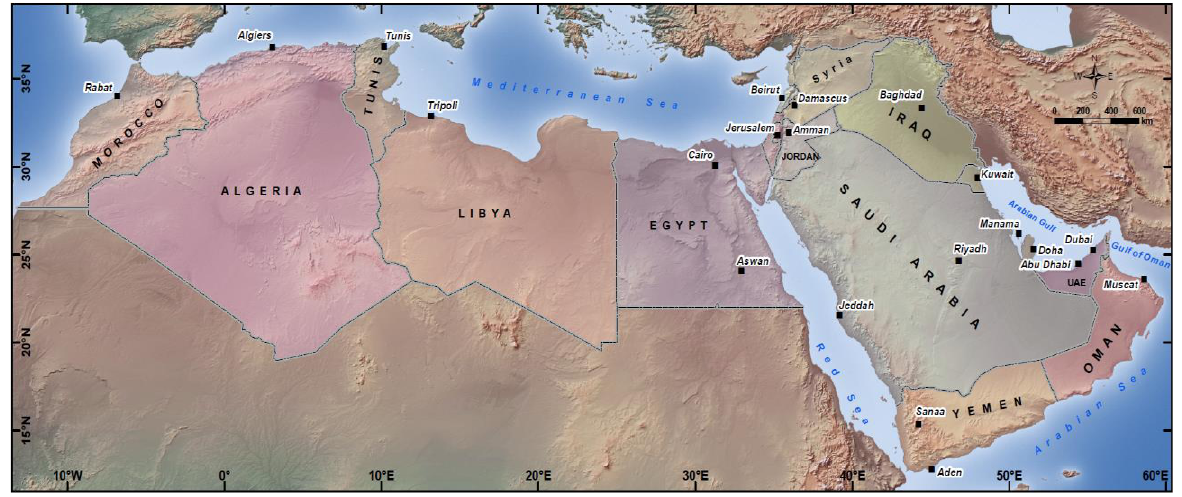
Figure 1. An overview of the study area in the MENA region.